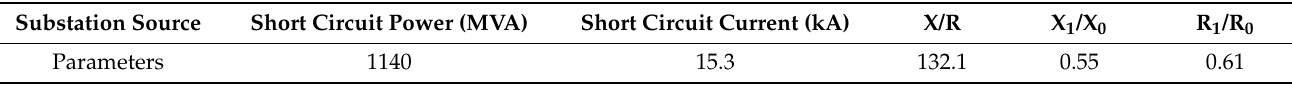
Table 4. Substation source parameters.